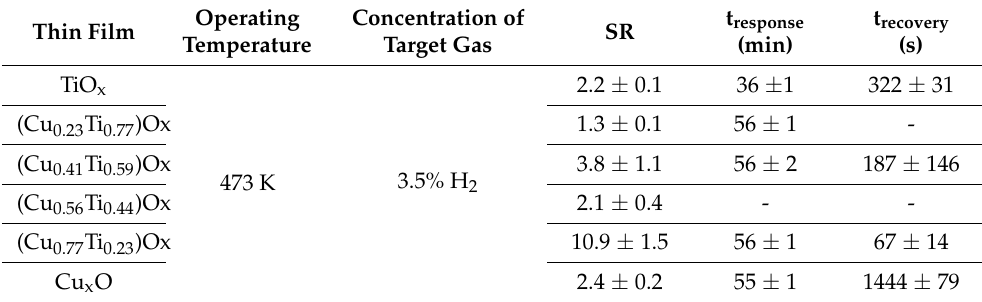
Table 4. Summary of sensing parameters of TiO x , Cu x O, and (CuTi)Ox thin films annealed at 473 K. Thin